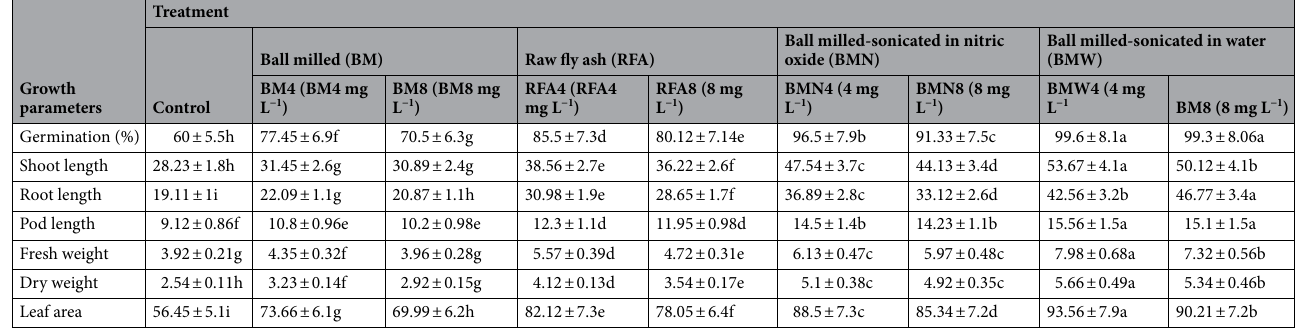
Table 2. Impact of CNP treatments on the growth parameters of Cicer arietinum seedlings. The standard deviations (SD) are for three replicates, and the different letters denote treatment differences that are statistically